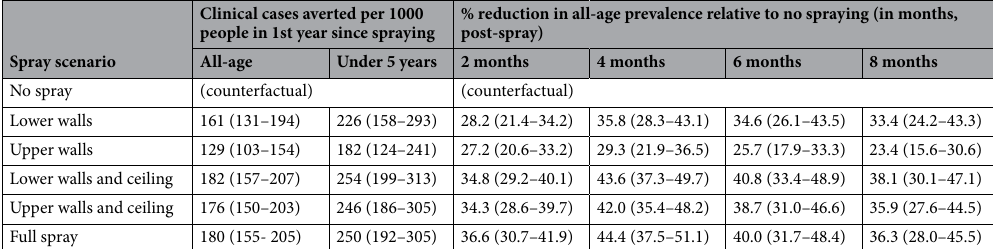
Table 1. Modelled estimates of the epidemiological effectiveness of partial versus full IRS with pirimiphos- methyl CS relative to no spraying in a setting similar to northern